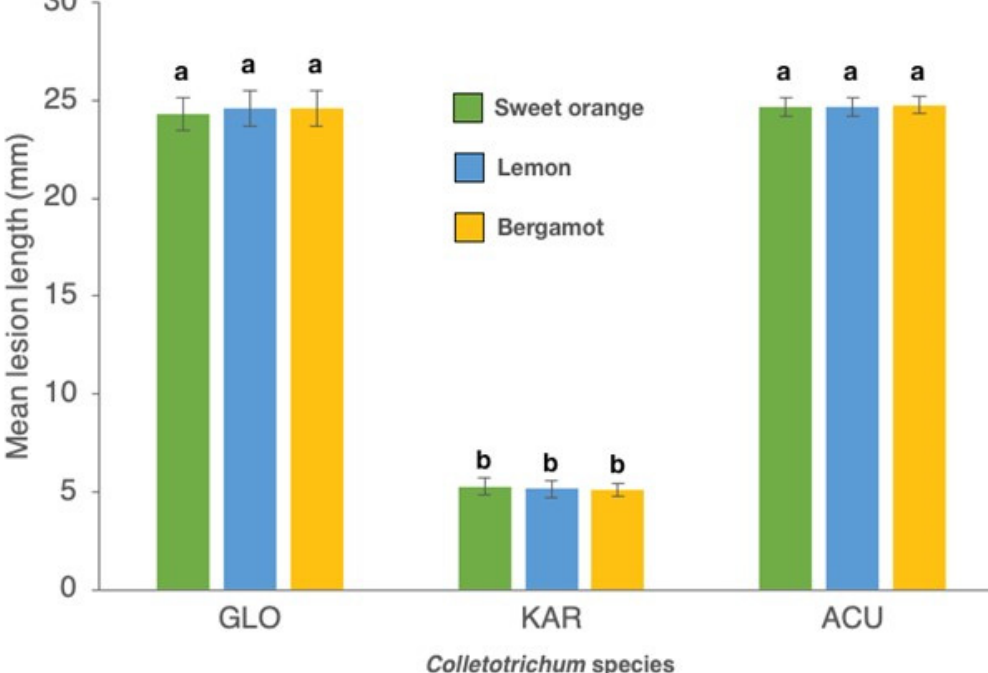
Figure 7. Mean length (mm) of necrotic lesions of six twigs per each of three replicated trees (± SD) induced by isolates of Colletotrichum gloeosporioides (GLO) (five isolates, means of 90 replicates), C. karstii (KAR) (three isolates, means of 54 replicates) and C. acutatum (ACU) (one isolate, means of 18 replicates) on in-field artificially inoculated twigs of sweet orange “Scirè VCR”, lemon “Femminello 2kr” and bergamot “Fantastico”, 14 d.p.i. Values sharing same letters are not statistically different according to Tukey’s honestly significant difference (HSD) test ( p ≤ 0.05).